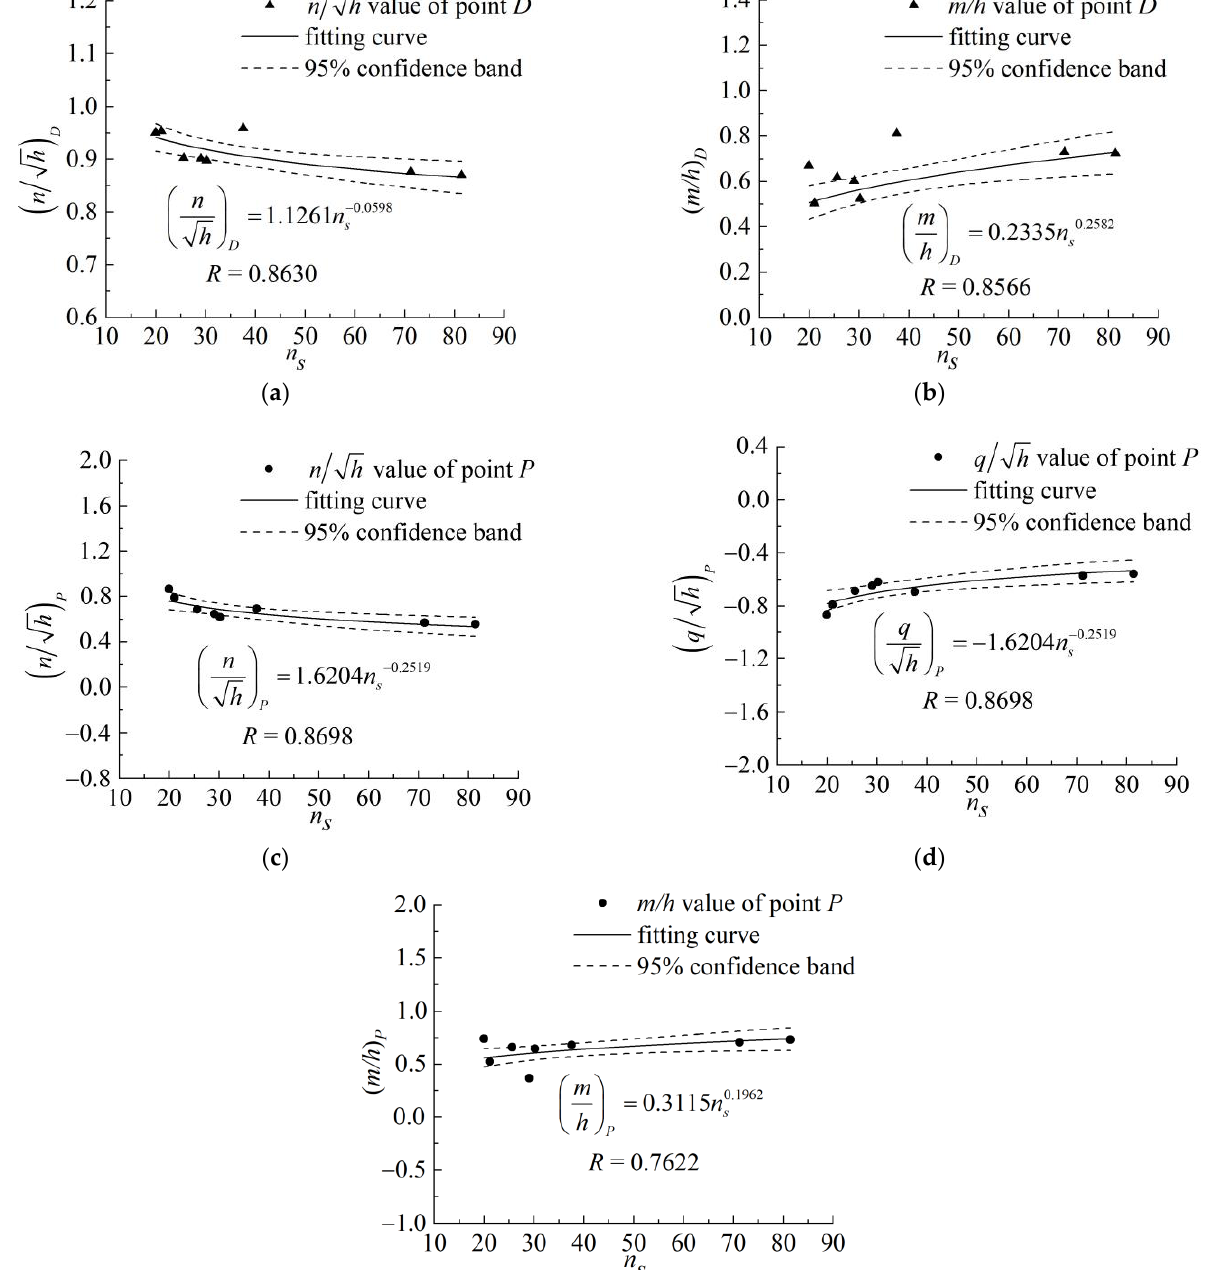
√ (cid:16) (cid:17) − 𝑛 𝑠 ; ( b ) − n s ; n / h 𝐷 D